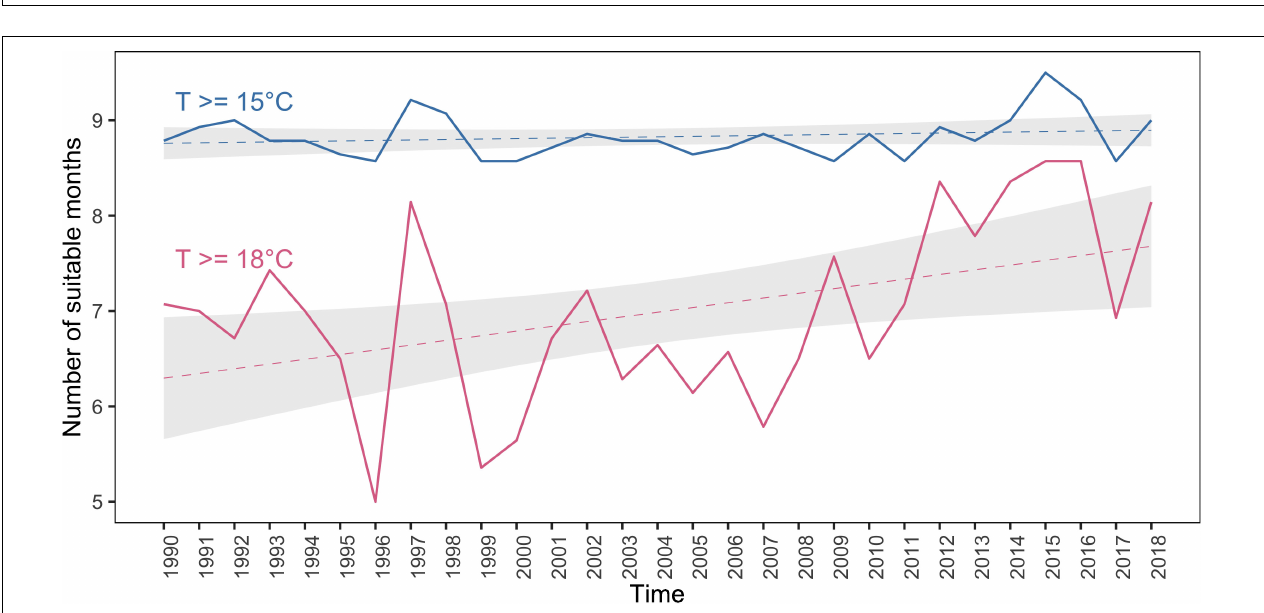
FIGURE 3 | Effect of minimum temperature (T min ) on the annual cycle of malaria in El Oro 1990–2018. Difference in the monthly random effect marginal posterior distributions for models of (A) P. falciparum and (B) P. vivax malaria that include minimum temperature (orange), lagged by 3 months and exclude minimum temperature (gray). Relative risk, on the log scale, is defined as the annual parasite incidence (API), log( ρ st ).